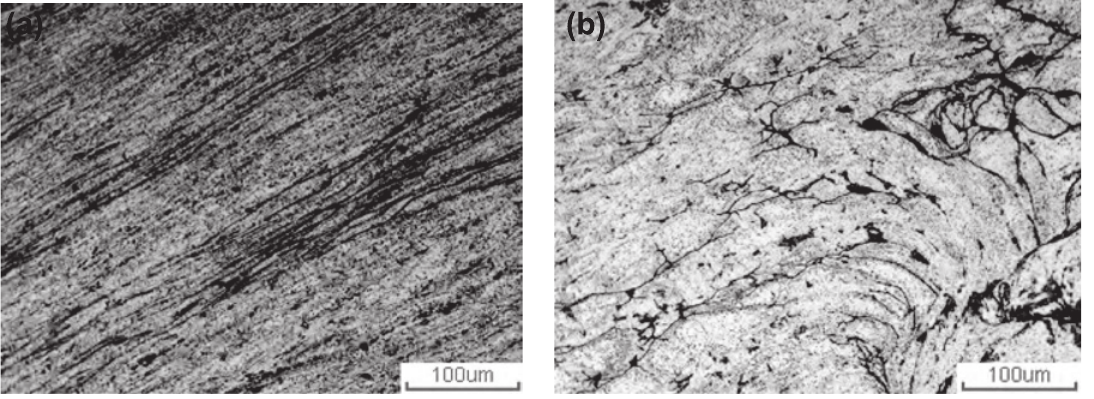
Fig. 7: Microstructures recorded in the instability domain of 7005 alloy, (a) adiabatic shear bands at 250 °C/0.5 s − 1 , (b) flow localization at 350 °C/0.5 s − 1